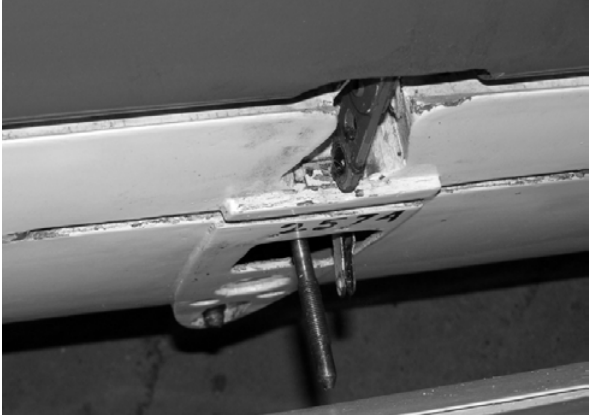
Fig 14. Relief for the beam and vertical pilot bar mounted into the stabilizer spar